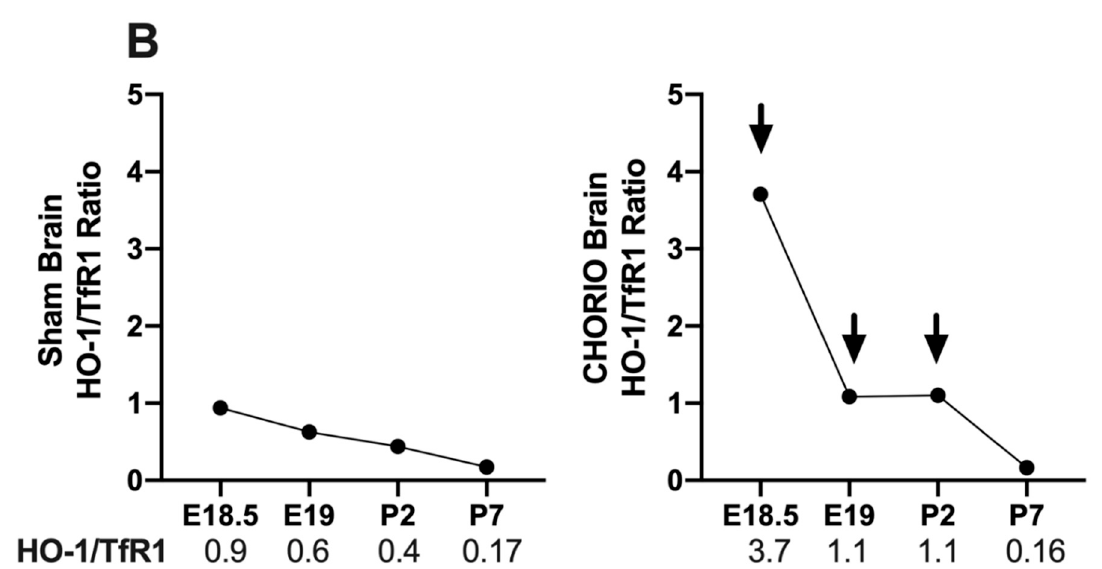
Figure 5. CHORIO-induced increase in HO-1/HO-2 and HO-1/TfR1 ratios in developing brain. Acute alteration of HO-1/HO-2 ratios in CHORIO brains compared with sham 6 h after initial insult ( A ). Initial acute alteration of HO-1/TfR1 ratios in CHORIO brains is sustained until P2, 7-days post initial insult in CHORIO brains compared with sham ( B ). Arrows indicate increased HO-1/HO-2 at E18.5 and HO-1/TfR1 at E18.5, E19 and P2 when compared with Sham.